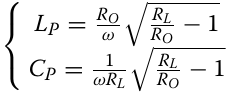
Fig. 2 Class E inverter ZVS operation area